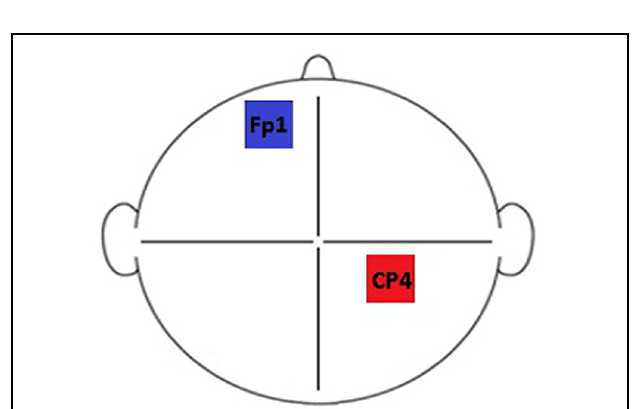
FIGURE 2 | Electrode montage. Electrodes were positioned at locations CP4 (right hemisphere/contralateral to the stimulus, anode) and Fp1 (left hemisphere, cathode) of the 10–10